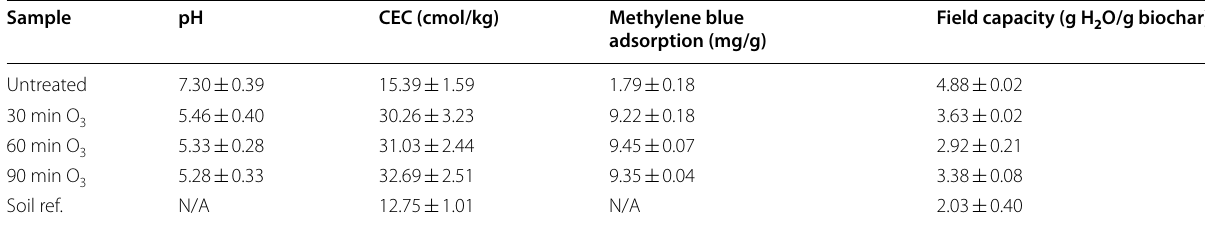
Table 1 Summary data for pH, CEC (cmol/kg), methylene blue adsorption (milligram dye adsorbed/gram biochar), and field capacity measurements (g H O/g 2